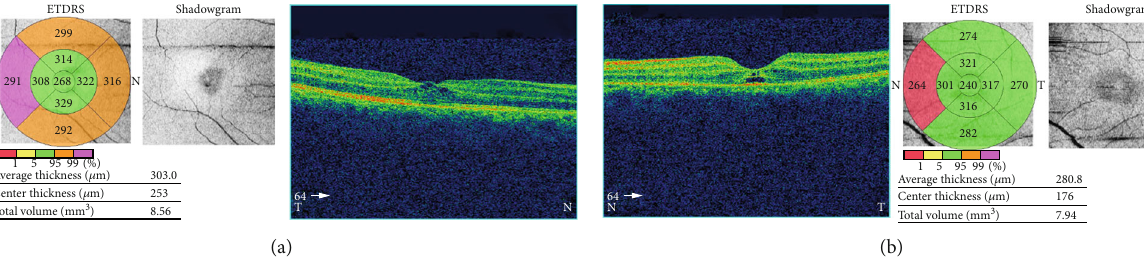
Figure 2: Spectral-domain optical coherence tomography (SD-OCT) at presentation. (a) Right eye with few intraretinal cystoid changes. (b) Left eye with a foveal cyst.